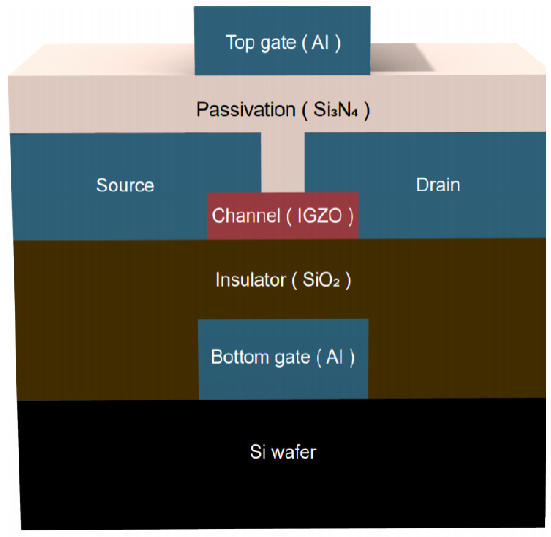
Figure 1. Schematic of an IGZO TFT with DG design.